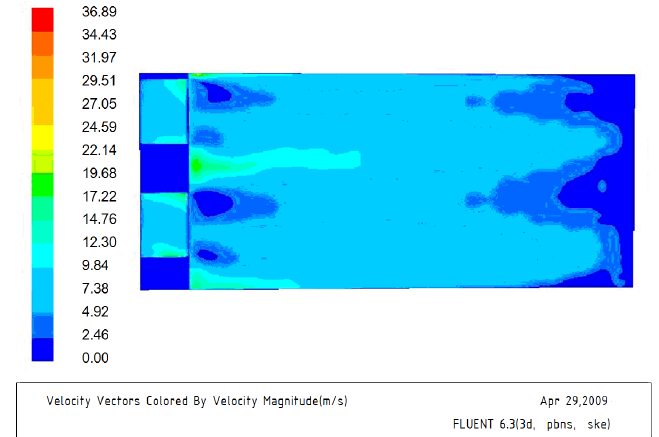
Figure 12. Cross-section velocity contour of the third